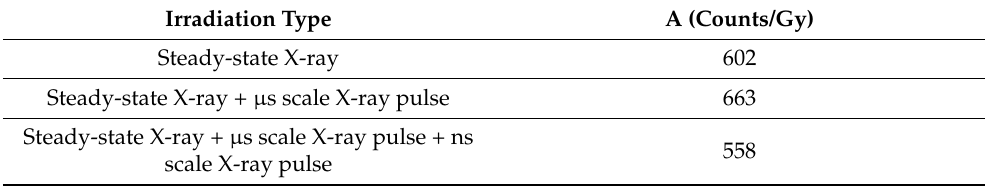
Table 1. Fit parameter used to interpolate RIL measurements.